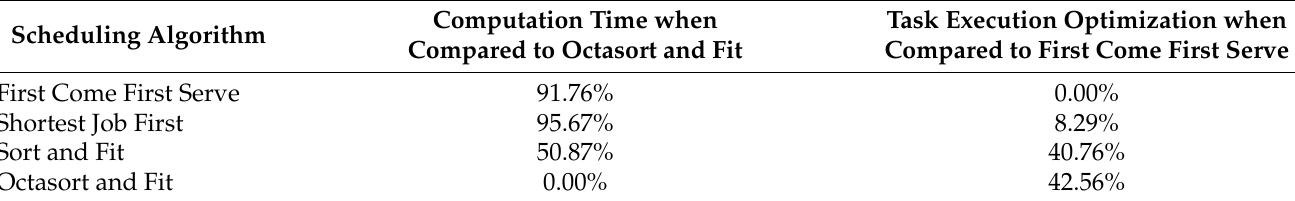
Table 1. Comparison between each scheduling algorithm in computation and optimization. Scheduling